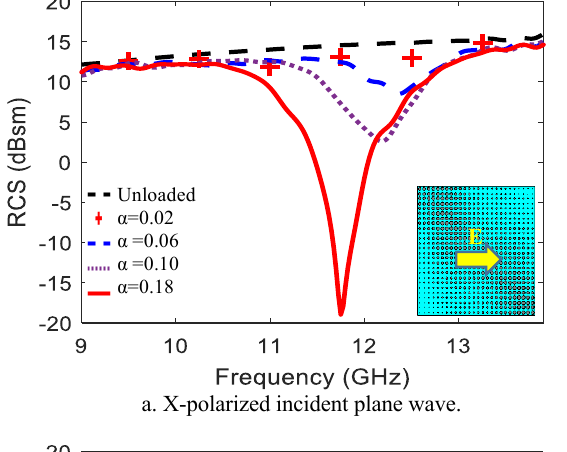
a. X-polarized incident plane wave.